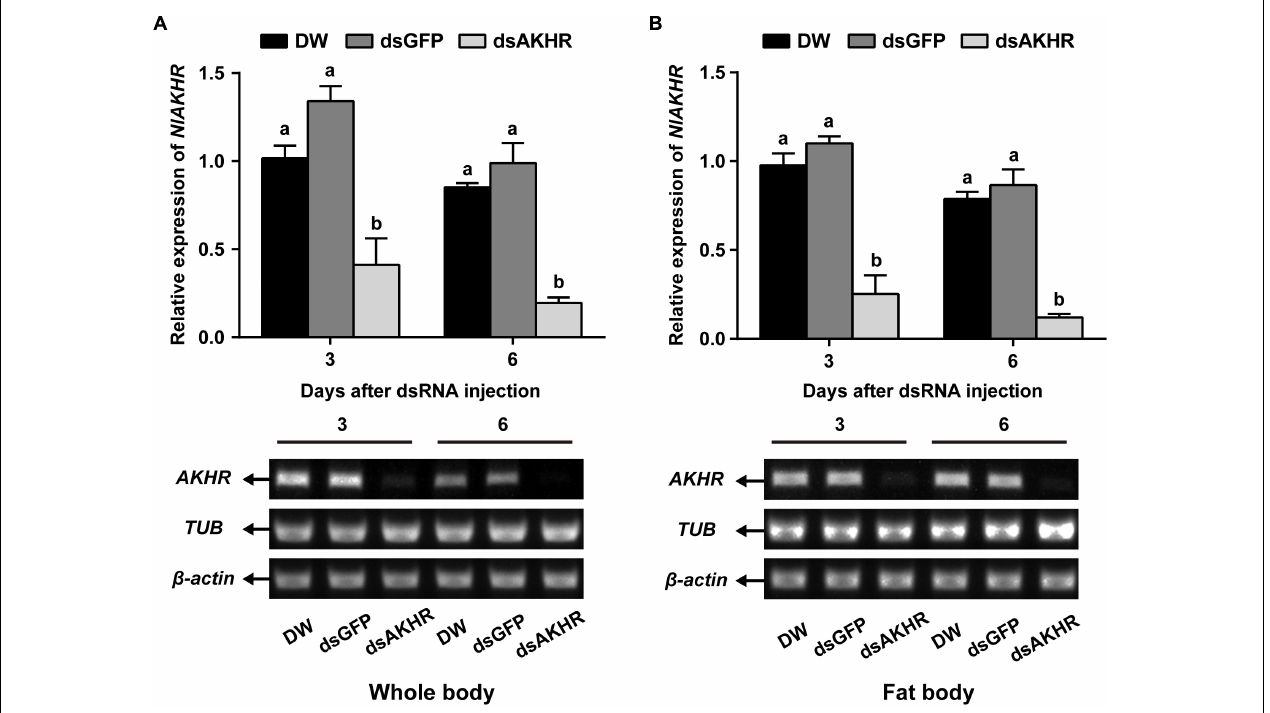
FIGURE 1 | Knockdown efficiency of NlAKHR after double-stranded RNA (dsRNA) injection in Nilaparvata lugens . Newly emerged females were injected with DEPC-treated water (DW) or dsRNA for NlAKHR or GFP (control) genes. Whole body (A) and fat body (B) samples were obtained on the 3rd and 6th day after injection, respectively. Differences between NlAKHR expression levels were determined by RT-PCR and qPCR analyses. The results are represented as means ± SE from three independent experiments. Different lowercase letters above the columns represent significant difference at P < 0.05 using one-way ANOVA followed by Duncan’s multiple